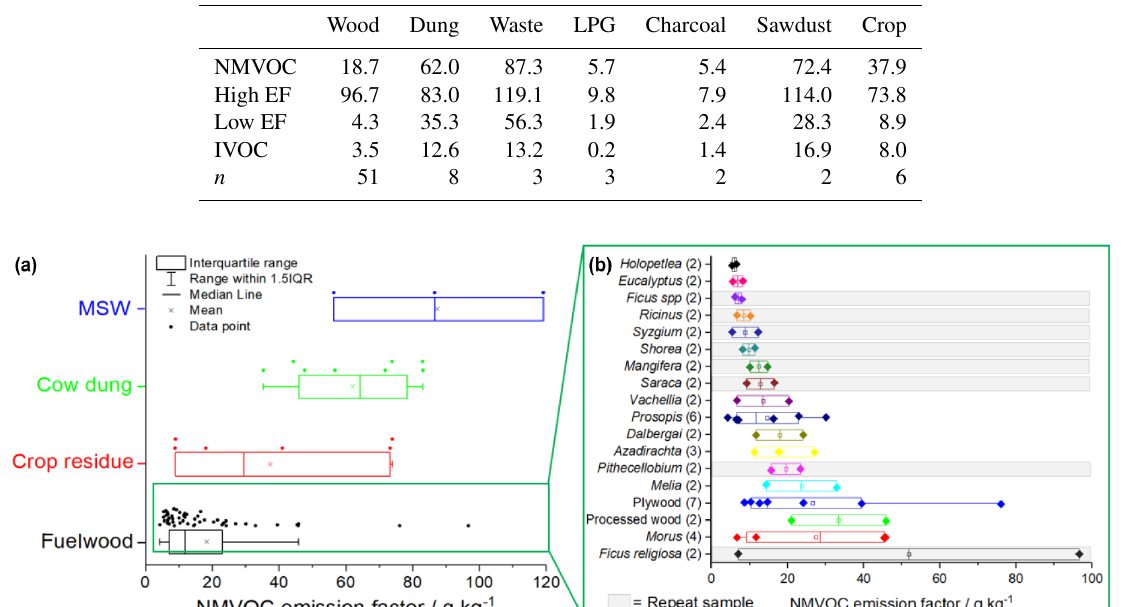
Table 2. Mean total measured NMVOC emission factors (gkg − 1 , including IVOC fraction) where high and low EF represent the largest and smallest emission factors, respectively, measured for a given sample type (gkg − 1 ); IVOC is the sum of emission factors of species with a mass greater than benzaldehyde (gkg − 1 ), where n represents the number of measurements made.